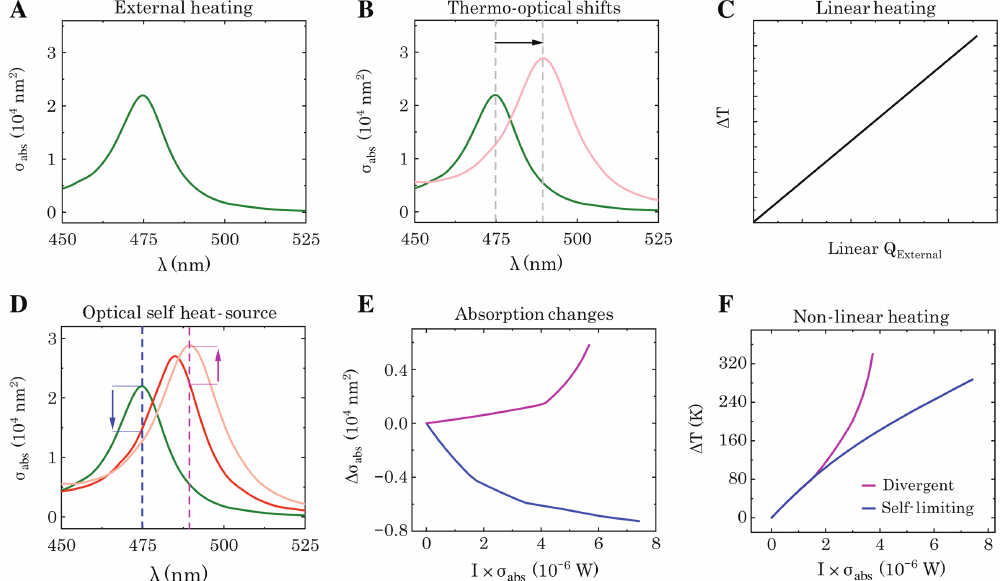
Figure 2: Relationship between optical properties and